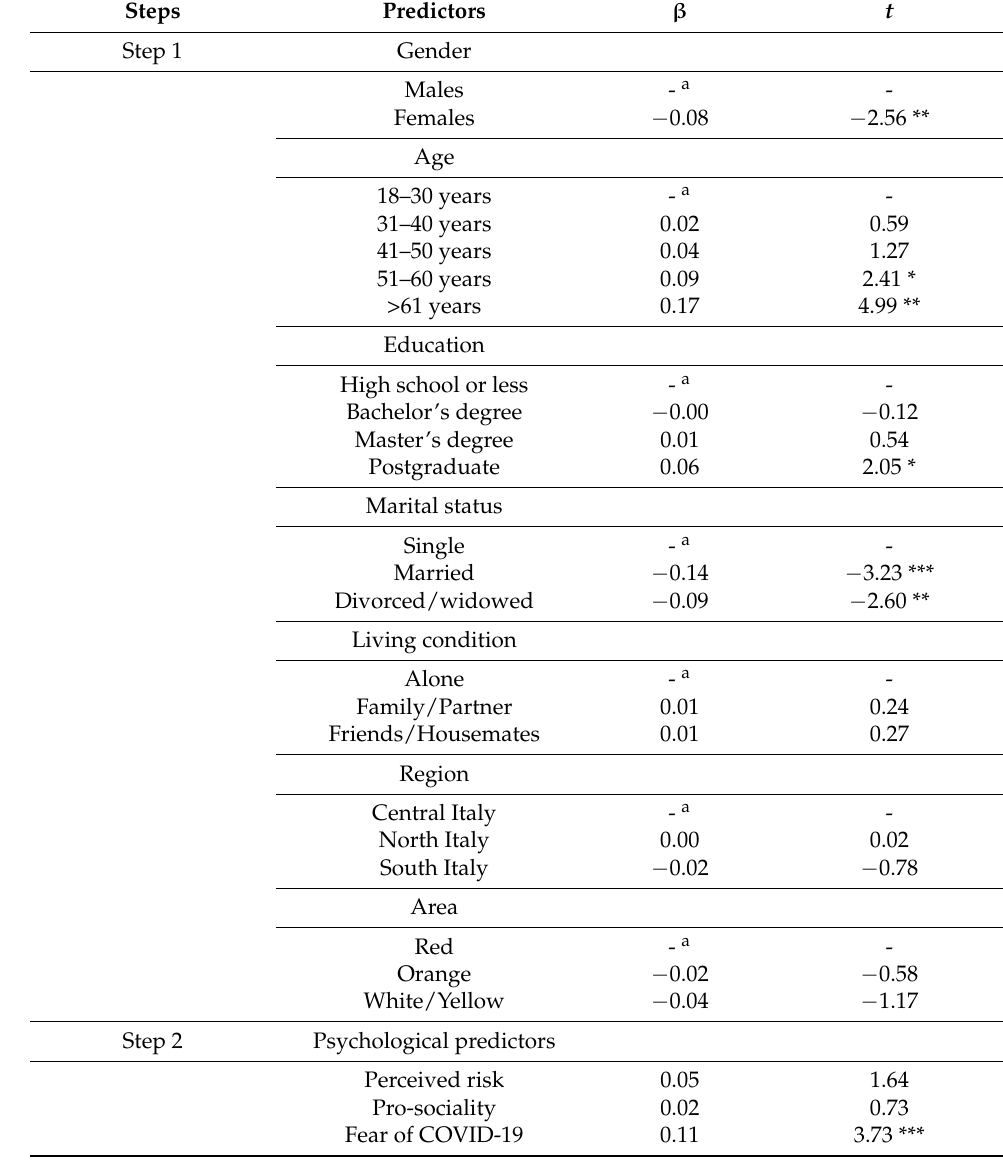
Table 5. Simultaneous regression predicting the intention to